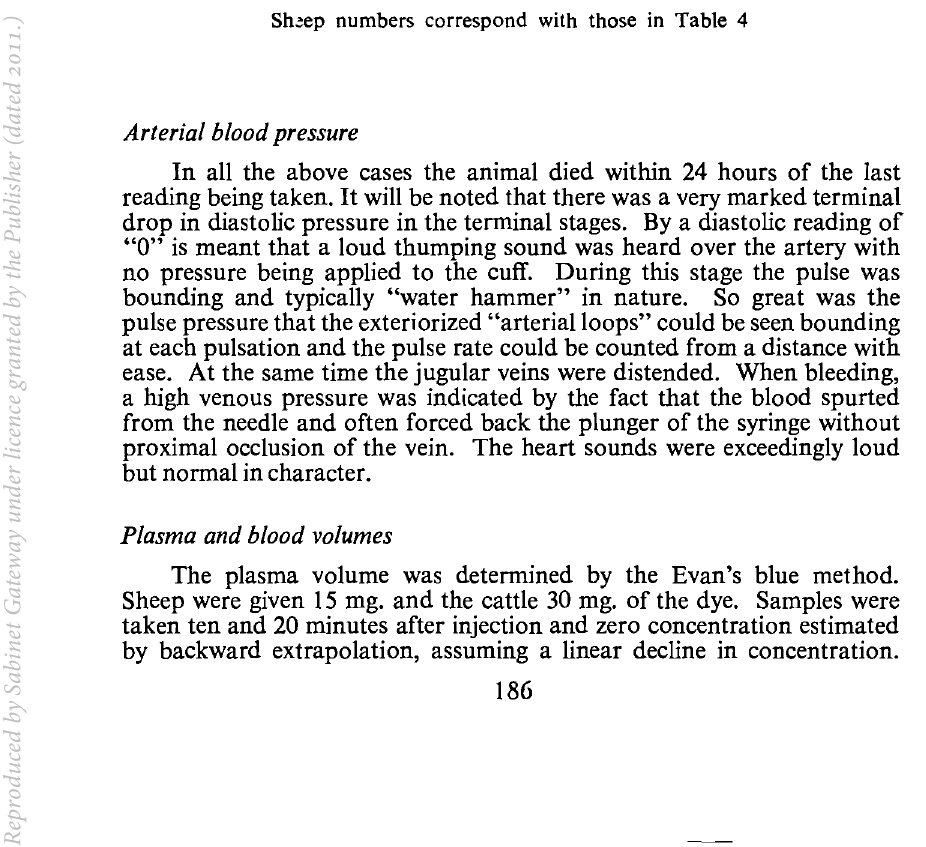
TABLE 3.-Carotid artery systolic and diastolic